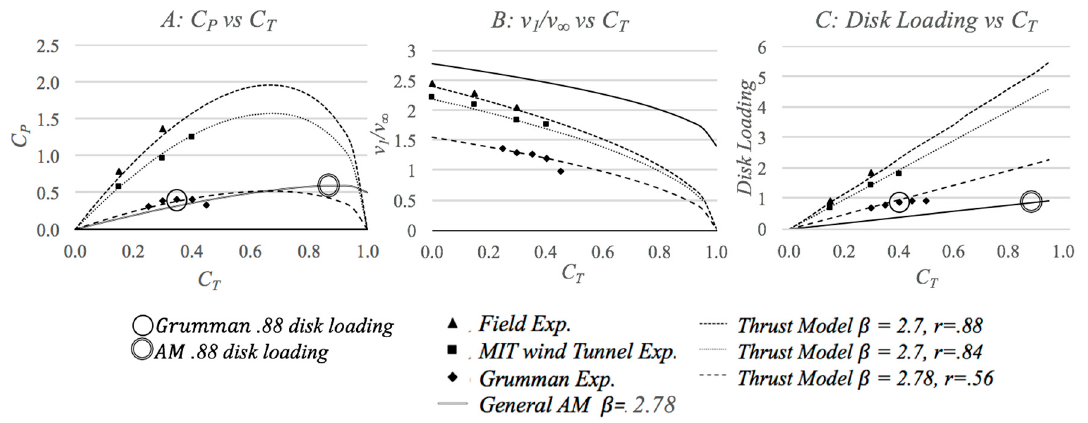
Figure 13. Thrust Model and general AM predictions compared to experimental results ( A ) C P vs. C T , ( B ) Velocity ratio vs. C T , ( C ) Disk Loading vs. C T .